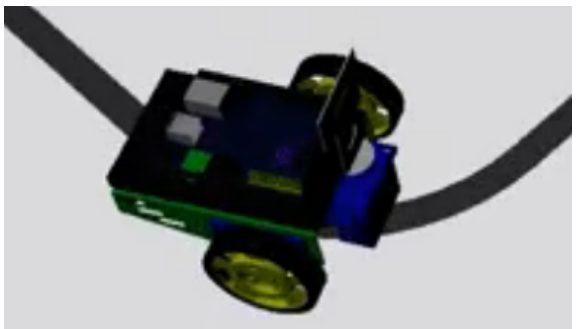
Figure 7. PiBot robot simulated in